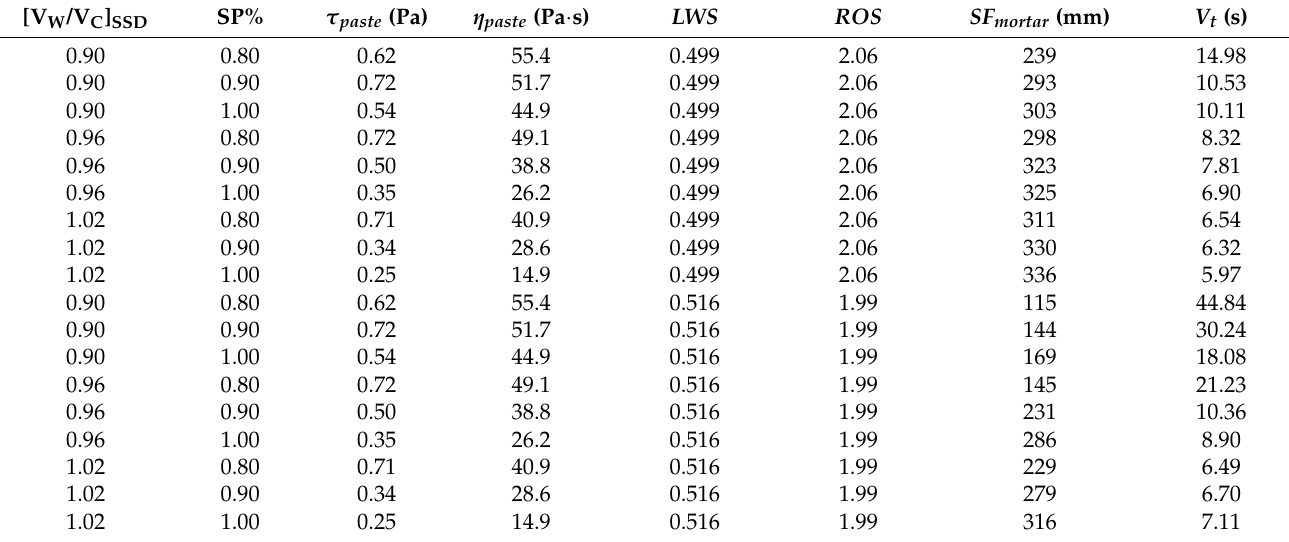
Table 5. Shape–weight parameters of sands and the test results of mortars and